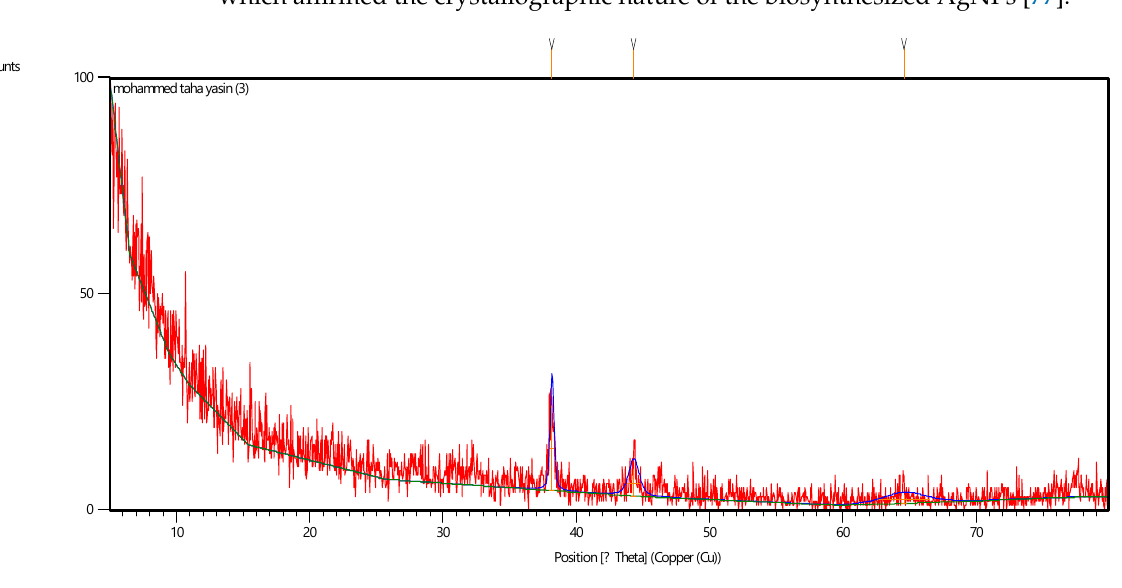
Figure 8. XRD pattern of the biosynthesized silver nanomaterials.